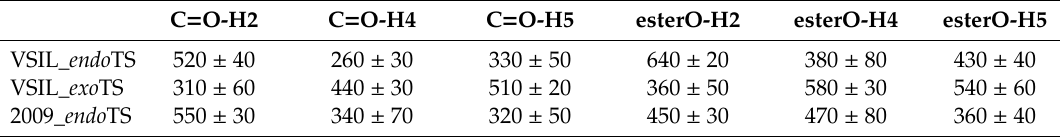
Figure 4. Angle between the normal to the C4 and H4 atoms on the imidazolium cation and the line connecting the carbonyl O atom of methyl acrylate as a function of the distance between BMIM and the substrate endo-cis transition structure for the Diels-Alder reaction in [BMIM][PF 6 ] using the OPLS-VSIL. Table 4. Average Distance (pm) Calculated Using a Nearest Neighbor Distribution Between the BMIM Ring Hydrogens (H2, H4 and H5) and Carbonyl Oxygen (C = O) or Ester Oxygen (esterO) from the Diels-Alder Endo-Cis and Exo-Cis Transition Structures in [BMIM][PF 6 ] using OPLS-VSIL and